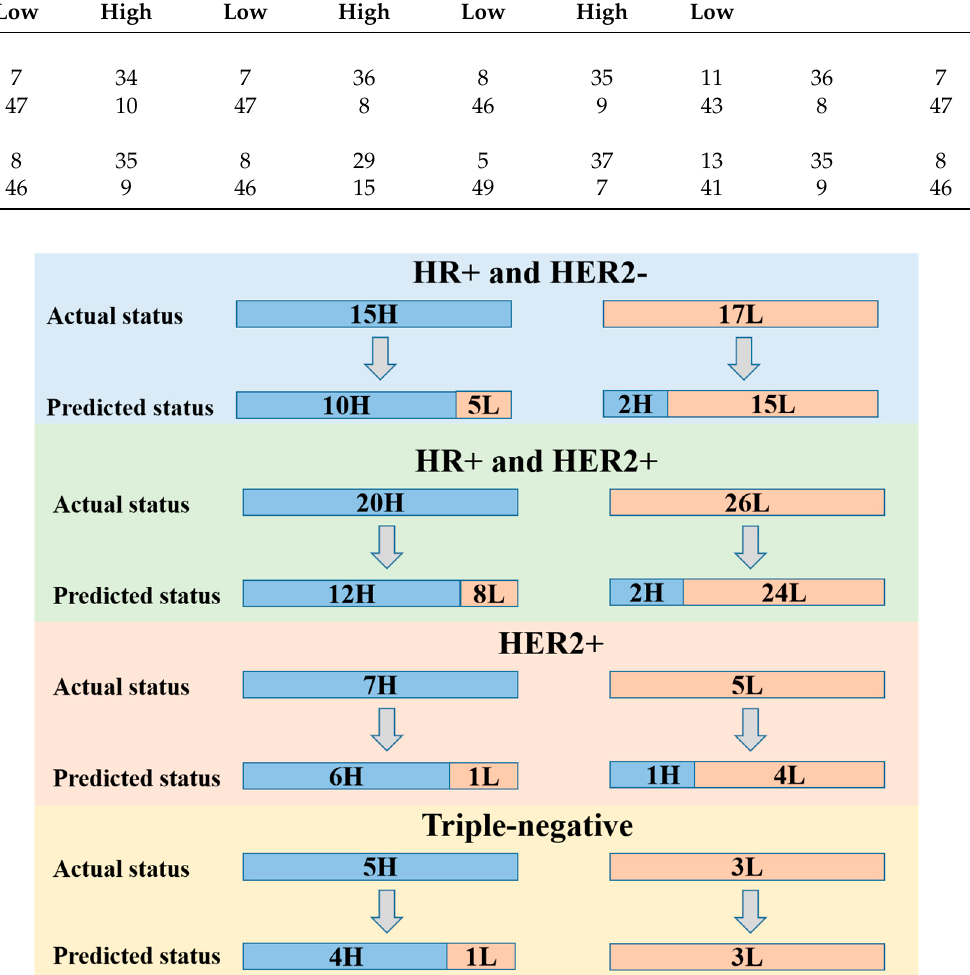
Figure 5. Stratified performance of the attention-based DenseNet121 DL model based on breast cancer molecular subtypes including HR+ and HER2 − , HR+ and HER2+, ER − , PR − and HER2+, and triple- negative subgroups. H, high TIL level; L, low TIL level; ER, estrogen receptor; PR, progesterone receptor; HER2, human epidermal growth factor receptor 2; HR, hormone receptor. Table 4. Stratified performance of the attention-based DenseNet121 DL model based on breast cancer molecular subtypes in EV cohort.